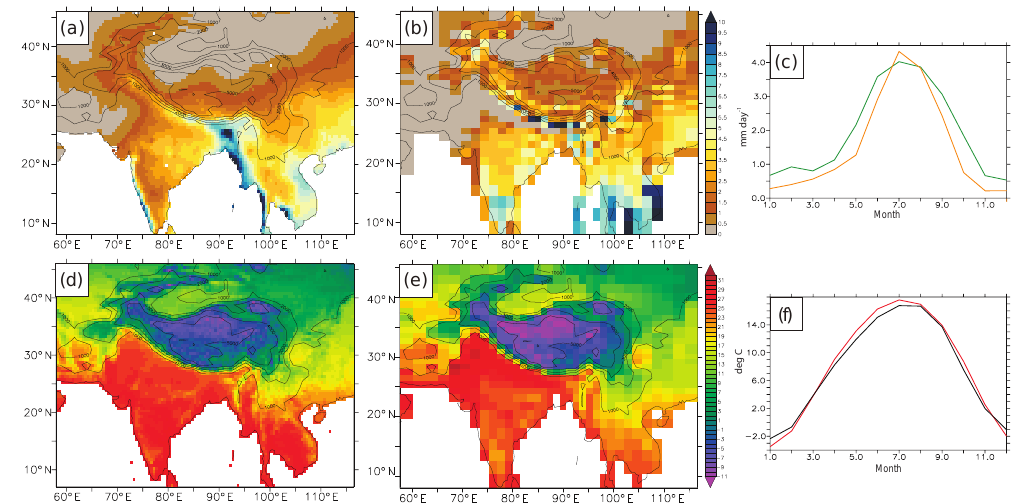
Figure 3. CRU dataset annual mean rainfall (mm/day) (a) and annual mean temperature ( ◦ C) (d) compared to simulated annual mean rainfall for MOD experiment (b) and simulated annual mean temperature for MOD experiment (e) . The seasonal cycles of averaged from 25 to 40 ◦ N and from 75 to 100 ◦ E for the MOD experiment precipitation (c) and temperature (f) . Green and red lines of figures (c) and (f) corresponds to MOD experiment, orange and black to the CRU dataset respectively.